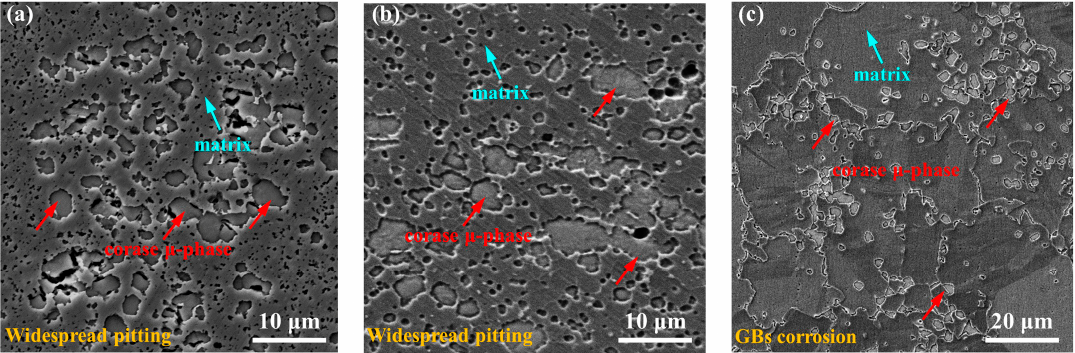
Figure 8. The corrosion morphology of the Mo 10 HEA in the 0.5 M H 2 SO 4 solution: ( a ) 850 °C − an- nealed sample; ( b ) 1000 °C − annealed sample; ( c ) the homogenized Mo 10 sample. Table 3. The electrochemical testing results obtained from Figure 7a.